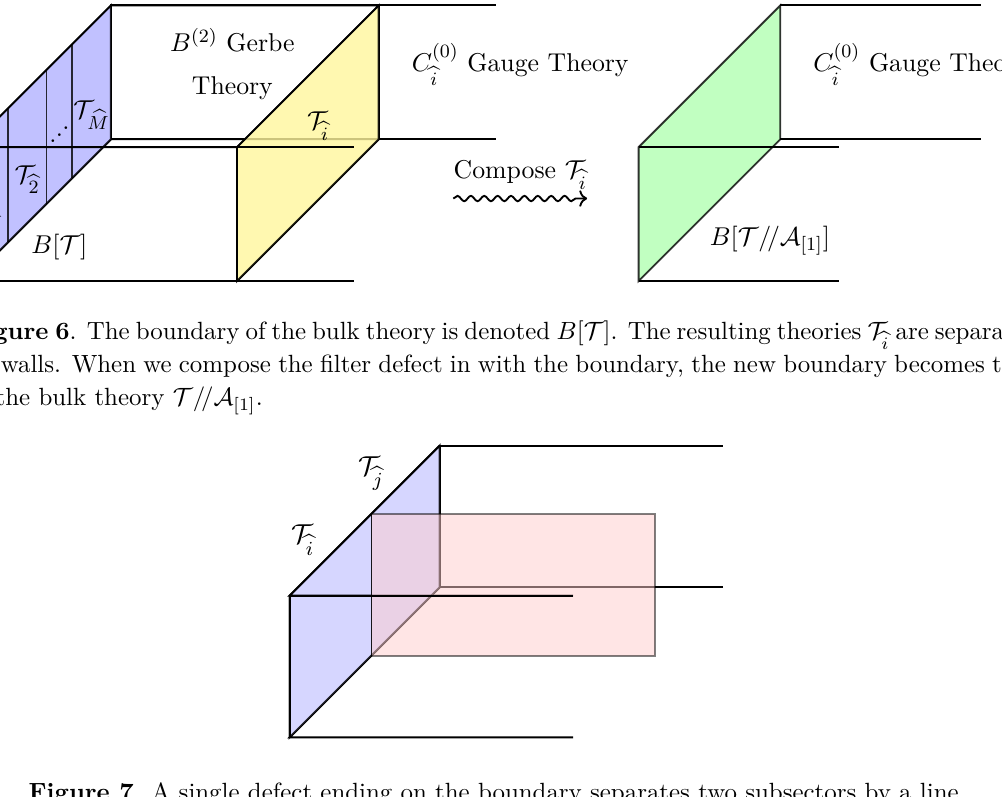
Figure 7 . A single defect ending on the boundary separates two subsectors by a